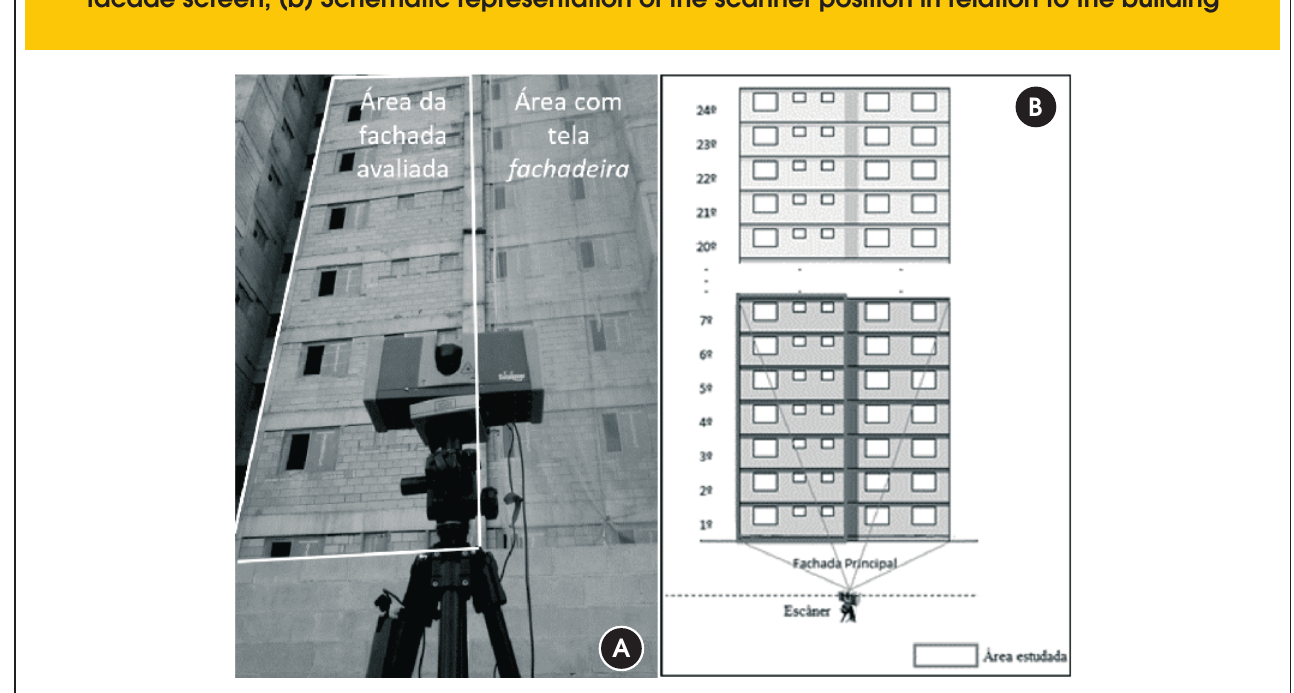
Figure 8 – (a) Image of the work showing a detail of the evaluated facade and the facade screen; (b) Schematic representation of the scanner position in relation to the